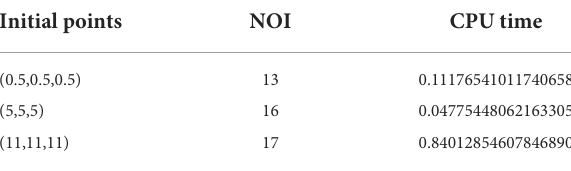
TABLE 3 Statistics of confirmed positive cases and death recorded from COVID-19 infection in Indonesia from March 2020 to May, 2022.